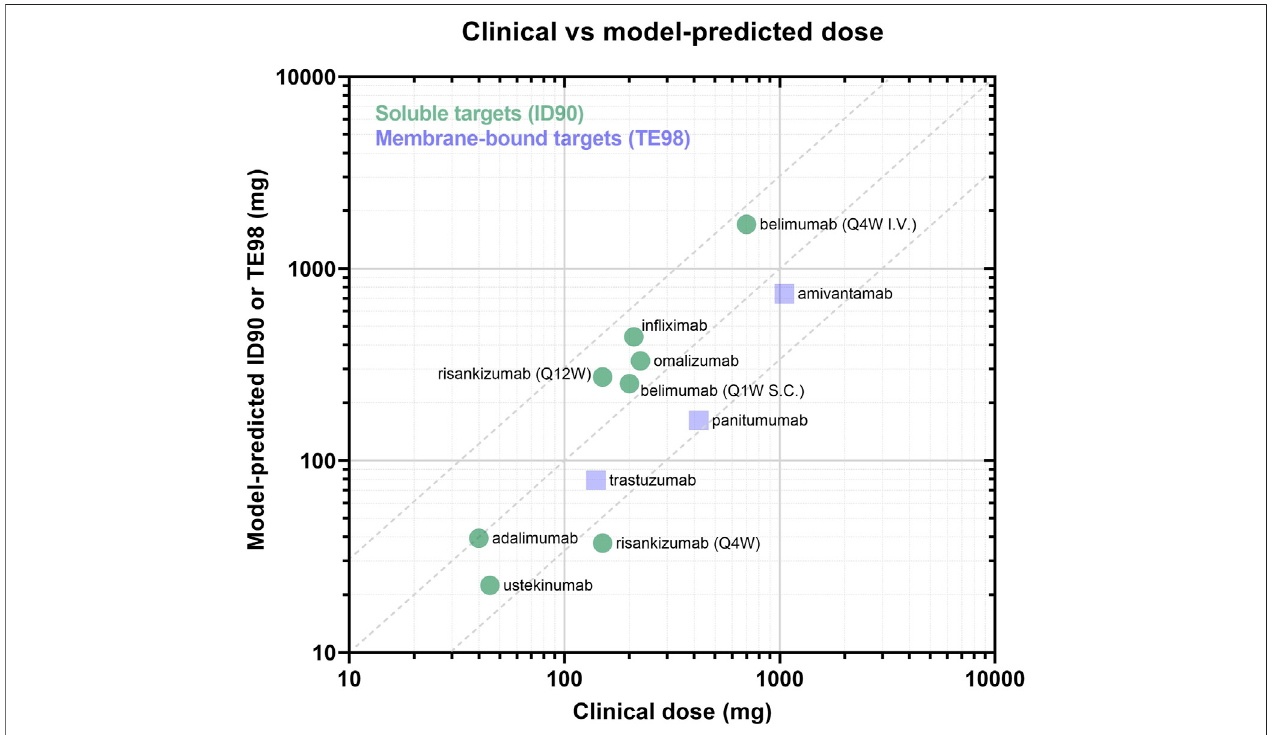
FIGURE 5 | Panel of model-predicted vs. clinically approved dose. Drugs with soluble targets are displayed as green circles and are evaluated based on ID90 (i.e., inhibition of baseline ligand:receptor complex). Drugs with membrane-bound targets are displayed in purple squares and are evaluated by TE98 (i.e., percent of target bound by drug). Dotted lines de fi ne the region where model-predicted effective doses fall within 3-fold of the clinically-approved doses.